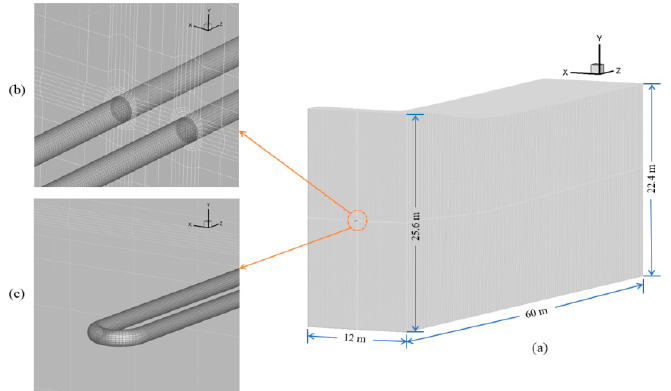
Figure 4. Mesh diagram of the simulation model. ( a ) Mesh of the whole zone; ( b ) mesh of the boundary layer of inside and outside of U-shaped tube; ( c ) mesh of the bend area.